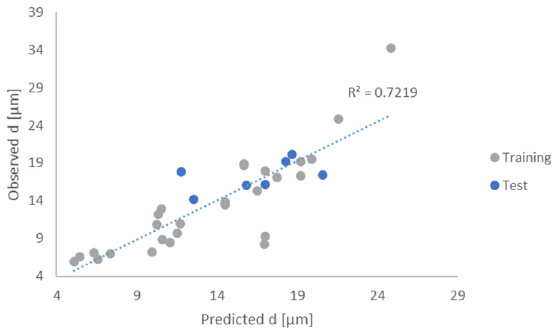
Figure 5. Observed vs. predicted graph for average droplet size for the training set used for model construction and test set used for model testing.